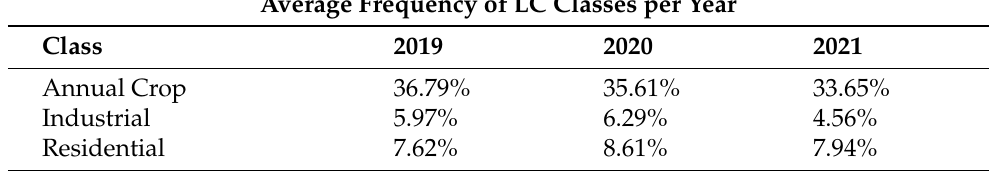
Table 4. Trends of relevant LC classes for 2019–2021.